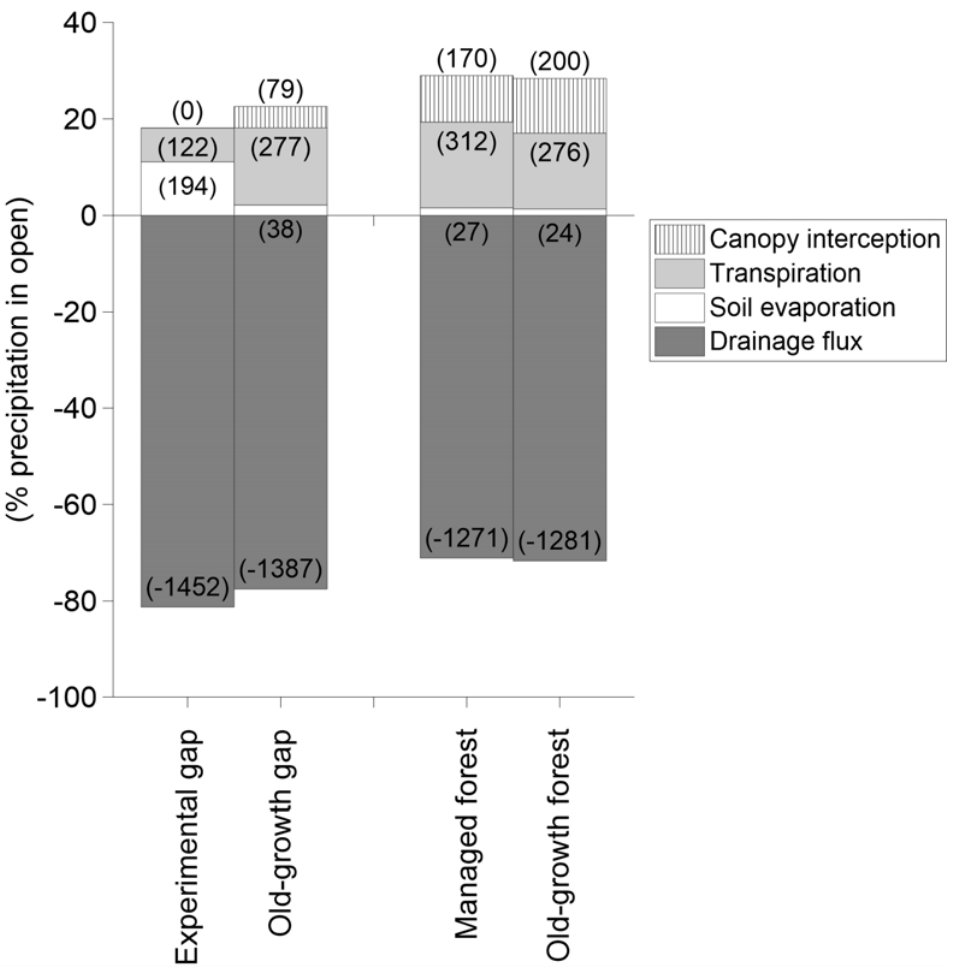
Figure 3. Mean annual canopy interception (I), transpiration (TRAN), soil evaporation (SE), and drainage flux (DF) (as % of precipitation in the open; P) in gaps and forests in the Dinaric Karst. Figures in brackets are values in mm.